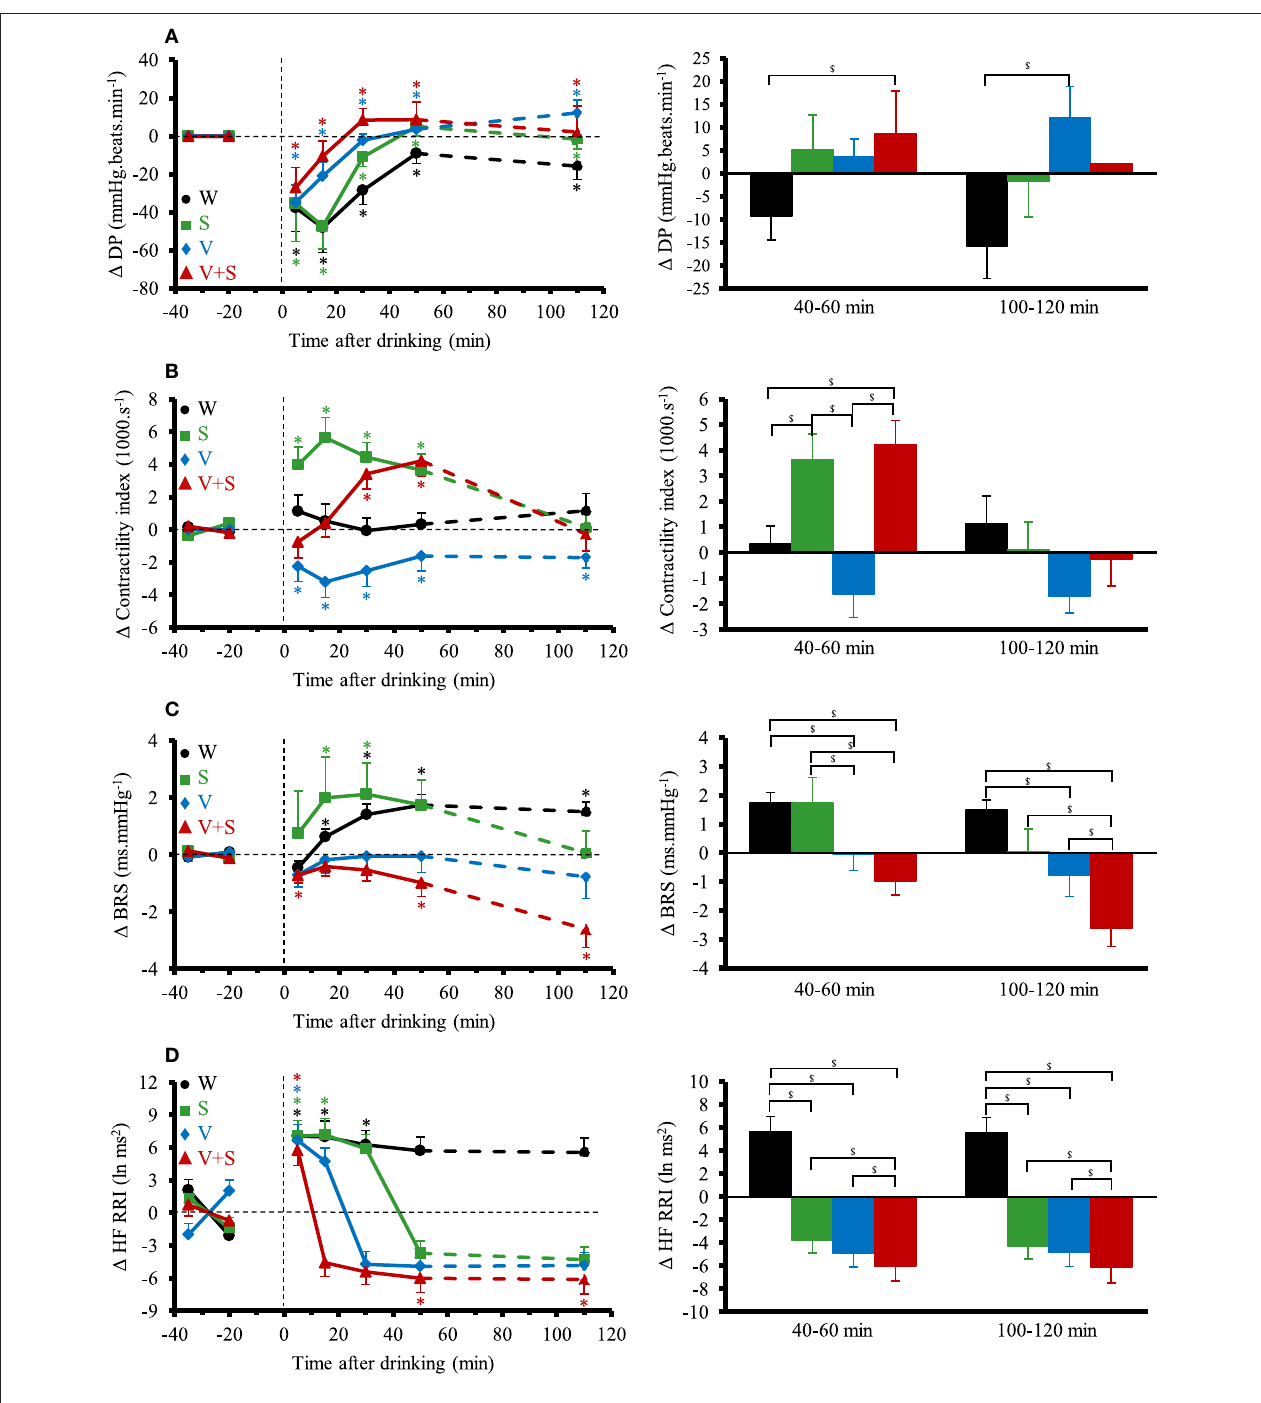
FIGURE 4 | (A–D) Left panel: time course of the changes in double product (A) , contractility index (B) , baroreflex sensitivity (BRS) (C) , and high frequency power components of RR intervals (HF_RRI) (D) . Right panel: mean responses averaged over 40–60 and 100–120min relative to baseline values and presented as a delta (i.e., average over 40–60 and 100–120min post-drink period, respectively, minus the average over the 30min baseline period). Drinks: water (W) , ; water + sugar (S) , ; water + vodka (V) , ; water + vodka + sugar (V + S) , . * p < 0.05 significant differences over time from baseline values; $ p < 0.05 significant differences between responses to the drinks.